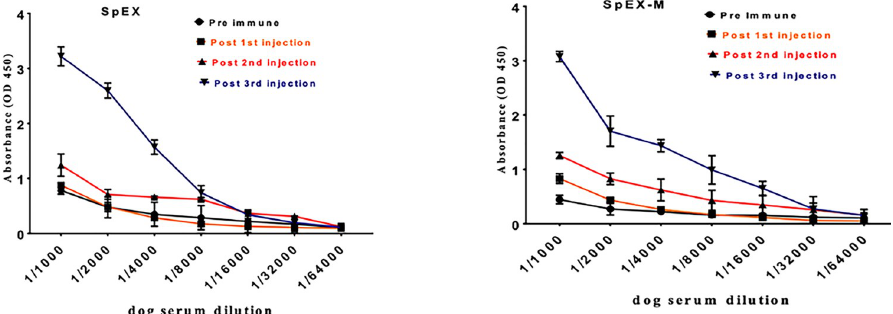
Fig 7. Dogs injected with SpEX-M developed IgG specifically reactive with recombinant native SpEX and SpEX-M. Antibodies against S . pseudintermedius native SpEX and SpEX-M were measured using an indirect ELISA. Recombinant S . pseudintermedius SpEX and SpEX-M proteins were coated on ELISA plates, then incubated with two- fold serially diluted serum from dogs vaccinated with the same proteins. High reactivity with SpEX and SpEX-M occurred with sera collected two weeks after the third injections of SpEX-M (P < 0.0001) compared to pre-injection sera. The values represent averages from three independent experiments.